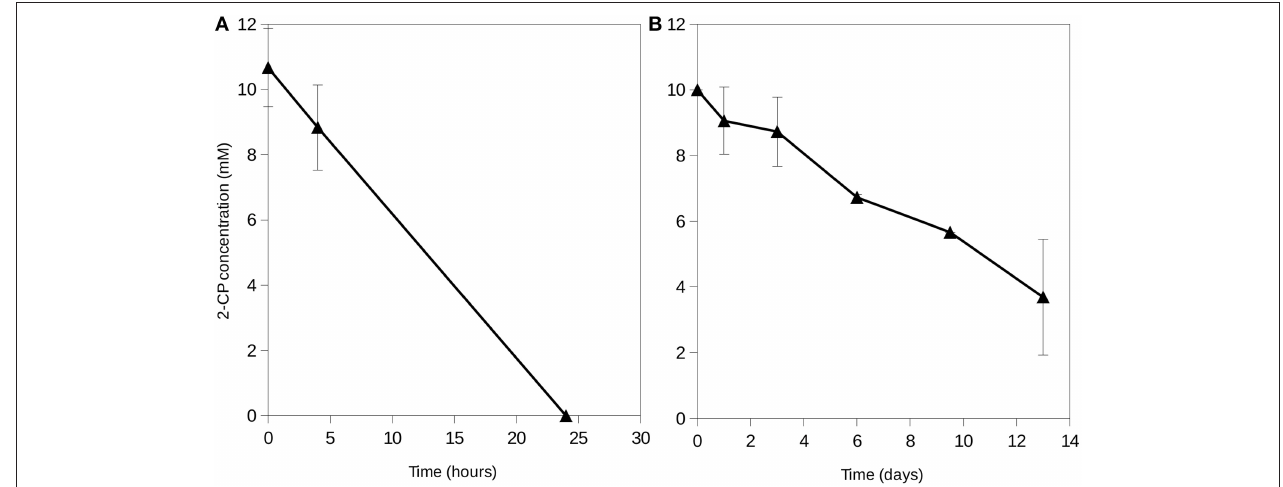
FIGURE 1 | Examples of the decay curves of 2-CP decomposition over time by Rhodococcus opacus ( A ; at a w 0.93) and Parageobacillus thermoglucosidasius ( B ; at a w 0.96) in soil